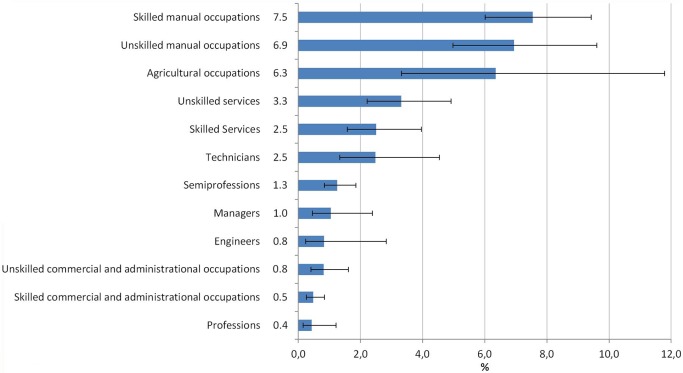
Occupational injuries within the past 12 months by occupational group (age 18–70), GEDA 2010, n = 14,041.